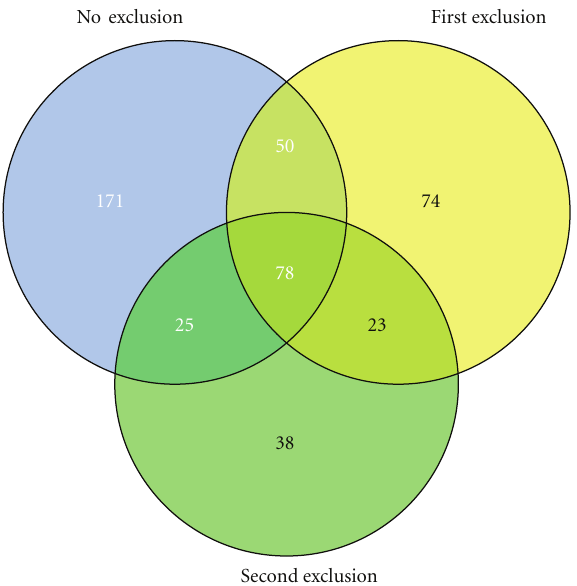
Figure 2: The benefit of using multiple exclusion MS runs. Venn diagram of the peptides identified in the first iTRAQ experiment. The no-exclusion run identified 324 distinct peptides. Of these 128 were identified in the first exclusion run together with 74 novel peptides. The second exclusion run produced 38 additional novel peptides that had not been identified in the no-exclusion or in the first exclusion MS